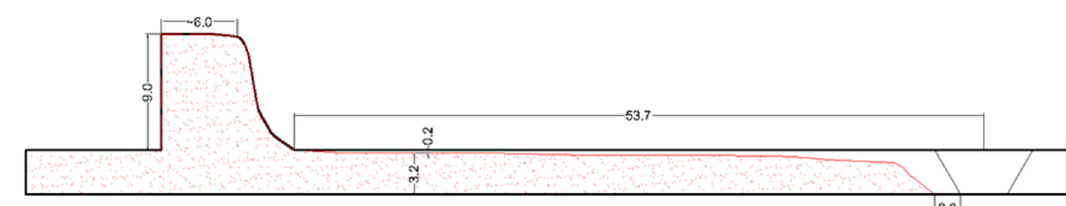
Figure 7. Sketch made at the site of the outburst at the Rudna mine in 2009 [39].